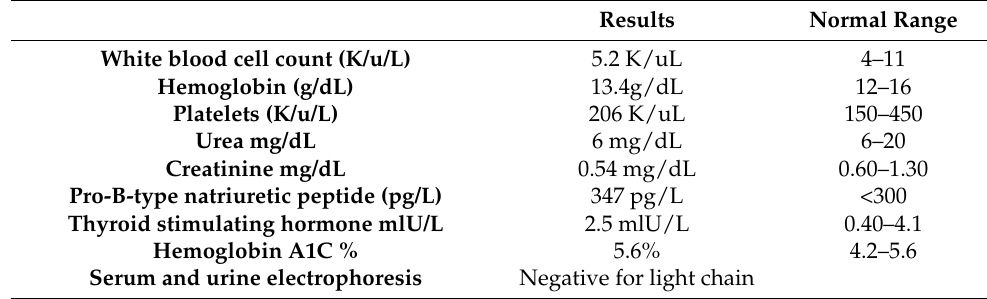
Table 1. Laboratory